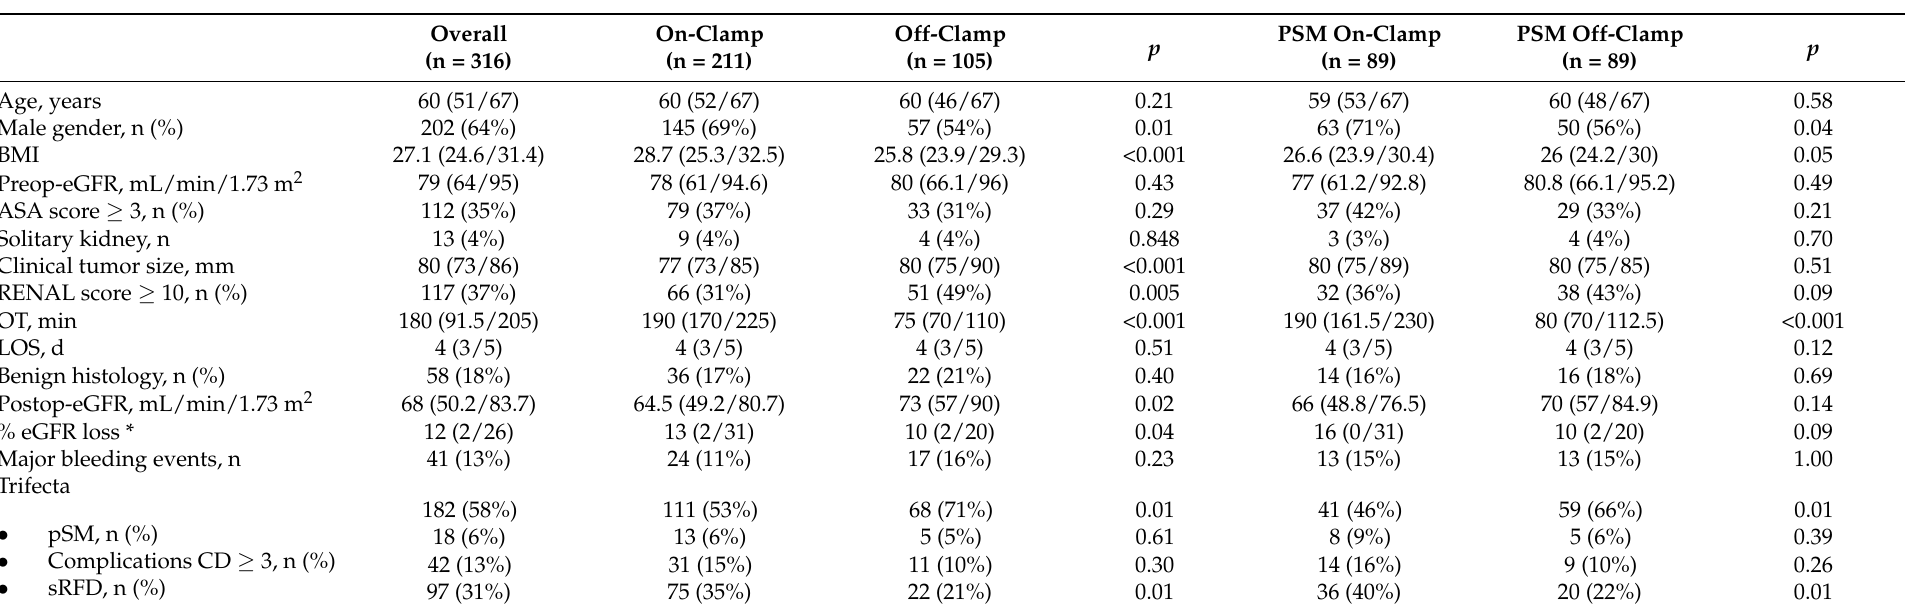
Table 1. Patients’ baseline characteristics and outcomes after robot-assisted partial nephrectomy, according to the clamping technique. Overall (n = 316)